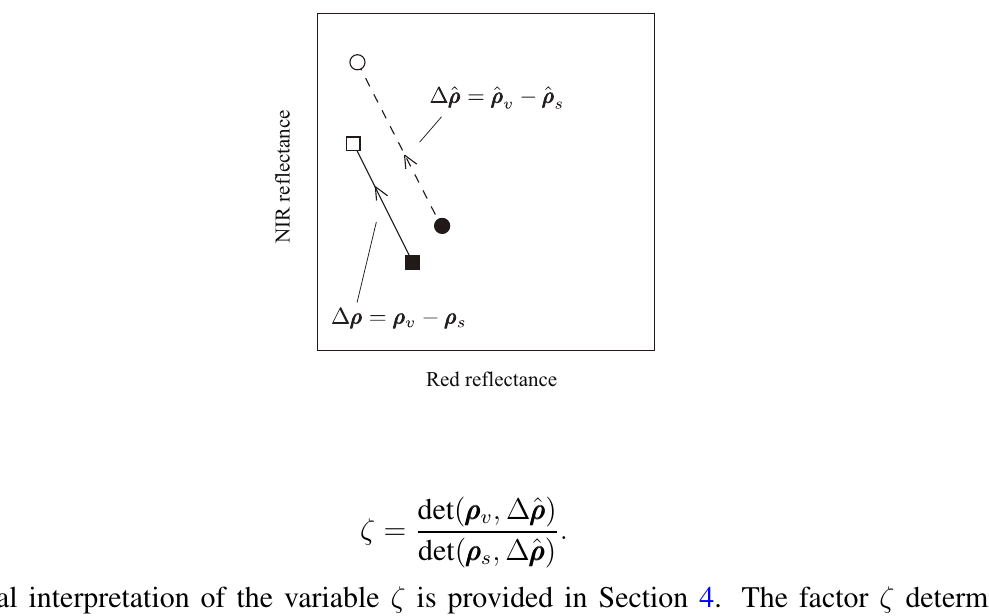
Figure 5. Illustration of the relationship between the vectors describing the true endmember spectra and the assumed endmember spectra ( ∆ ρρρ and ∆ˆ ρρρ ) in the red–NIR reflectance space. Empty and filled squares indicate the vegetation and non-vegetation endmember spectra in the target field, and empty and filled circles indicate the assumed endmember spectra in the LMM. When the two vectors are parallel, scaling effects are not observed in the average